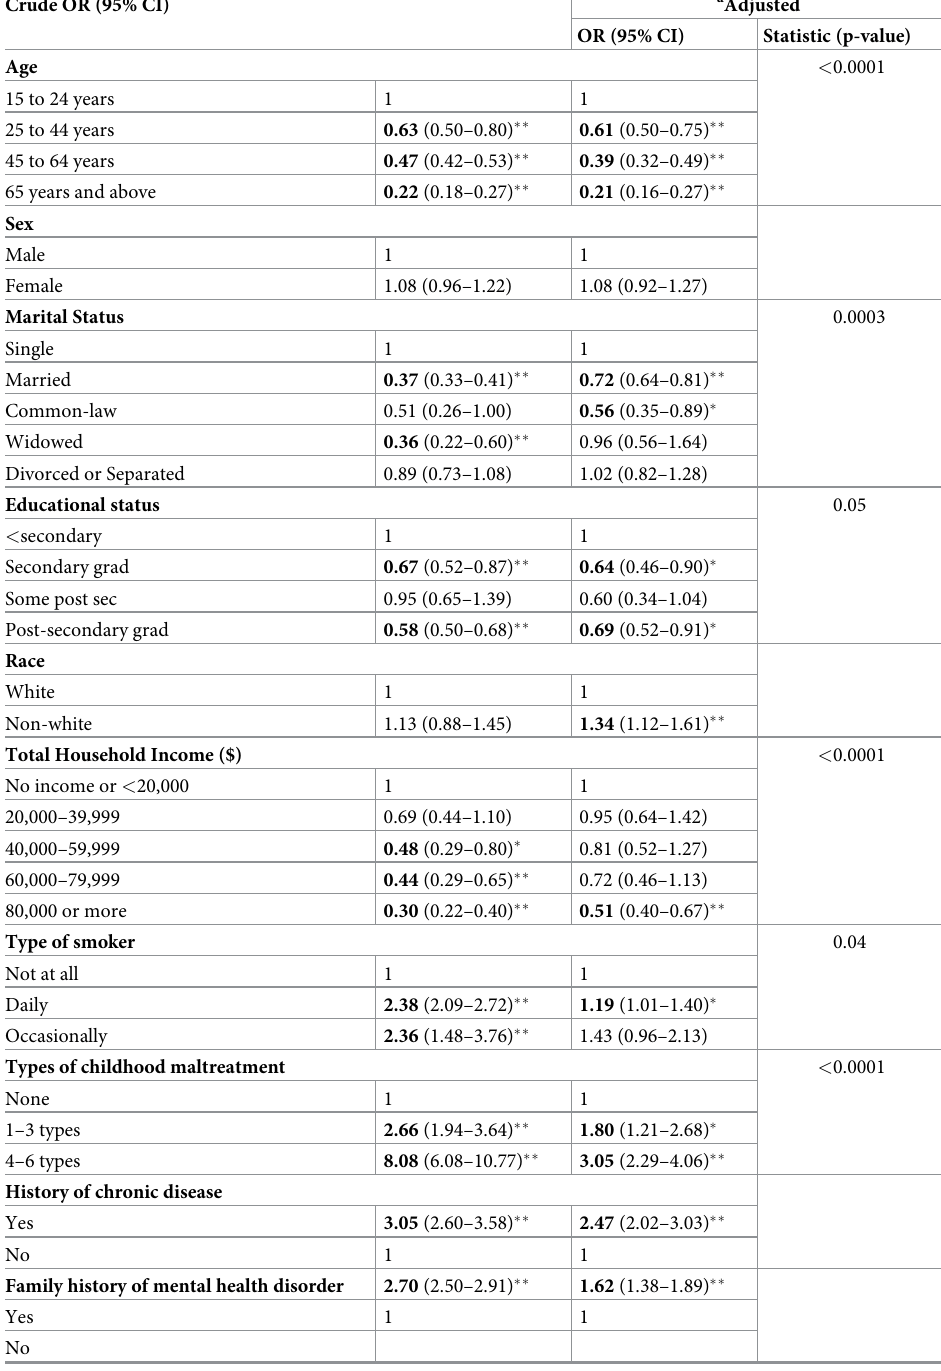
Table 2. Participants sociodemographic factors associated with 12-month suicide ideation (model